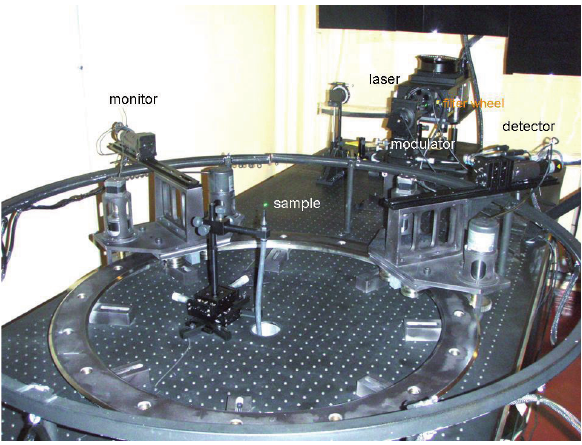
Fig 2: The Granada light scattering setup. A detailed description of the Granada light scattering setup can be found in [9].